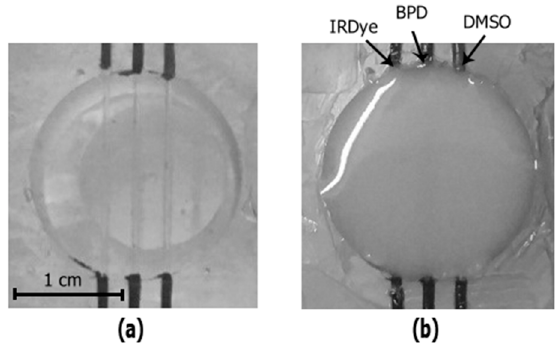
Table 1. Absorption coefficient μ a and reduced scattering coefficient μ s ’ of murine brain ex vivo and of the phantom at the excitation and emission wavelengths of BPD and IRDye800. Figure 4. Photography of the tubes containing the phantom filled with water ( a ) and agar mixture ( b